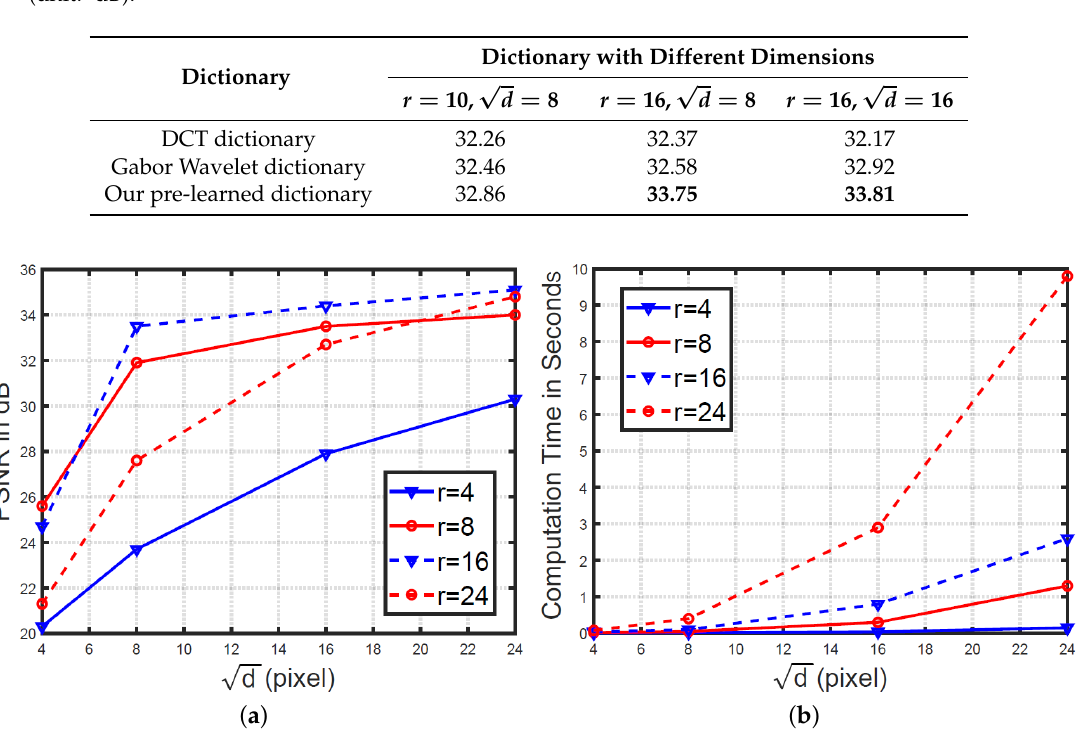
Figure 4. ( a ) PSNR and ( b ) computation time with dictionaries of different combinations of patch size and